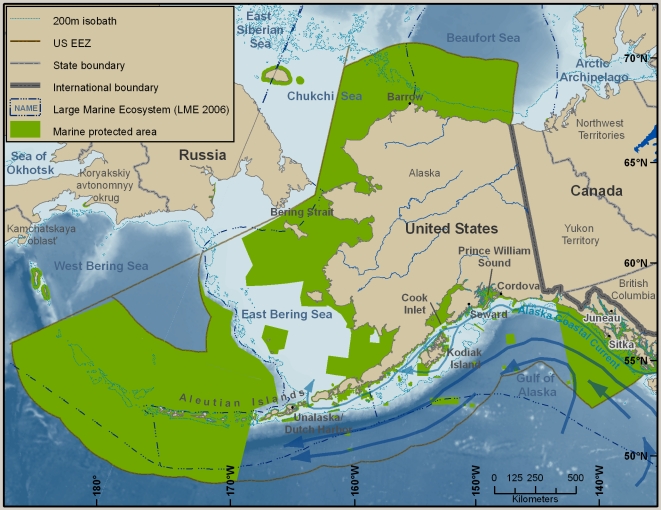
Gulf of Alaska, Bering Sea and Aleutians, and Chukchi and Beaufort seas.Map also shows large marine ecosystems, EEZ boundaries, state boundaries, international boundaries, marine ecoregions, and marine protected areas.